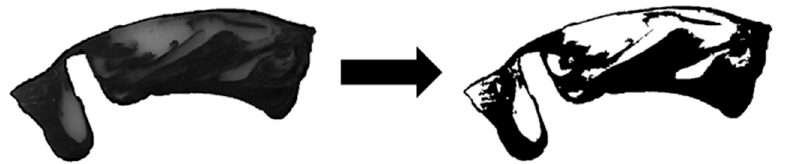
Figure 4. Solidification experiment: The solids and melt content along the wave zone, indicated by the white and black sections, respectively, were determined by image analysis.